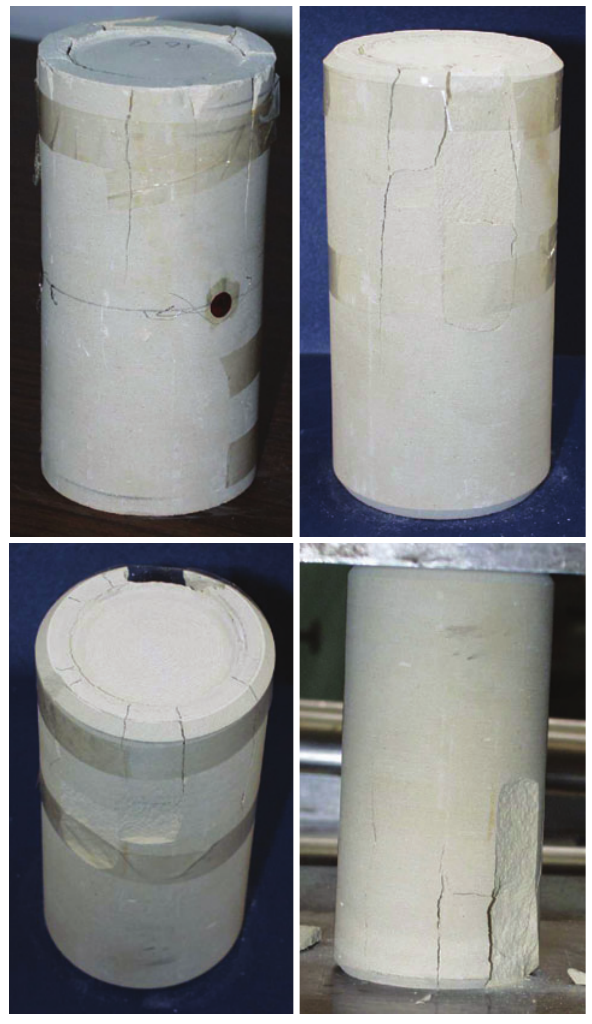
Figure 7 The failure mode of various ring type specimens made from Alfopetra stone.